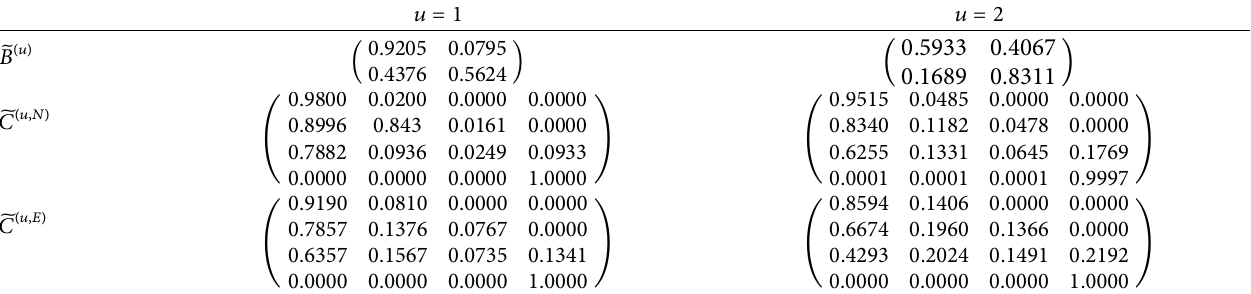
Table 1: Posterior inference for parameters of our specific TMM.